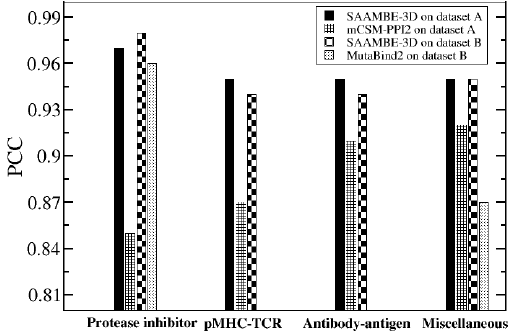
Figure 5. Complex specific performance of SAAMBE-3D, mCSM-PPI2 and MutaBind2.